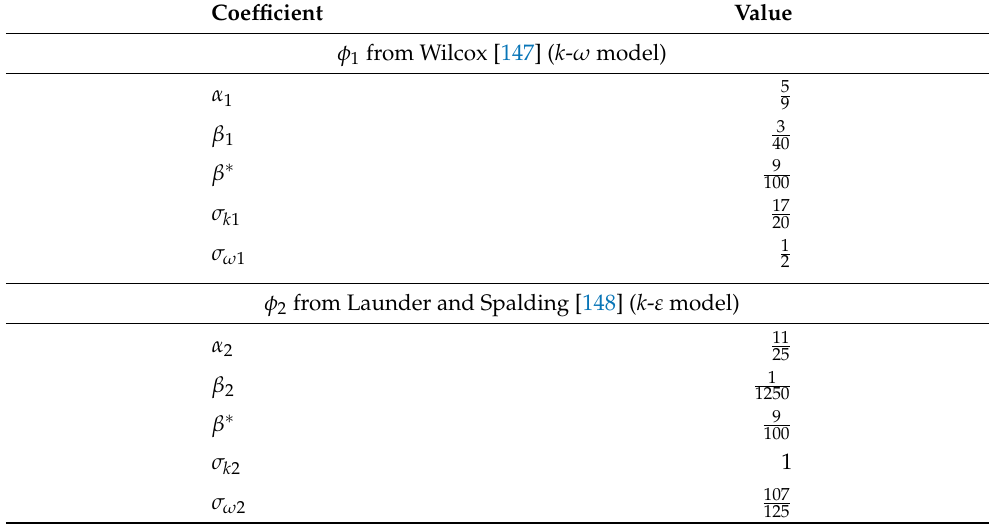
Table A1. Overview of the model constants used for the k - ω -SST turbulence model. Coefficient Value φ 1 from Wilcox [147] ( k - ω model) α